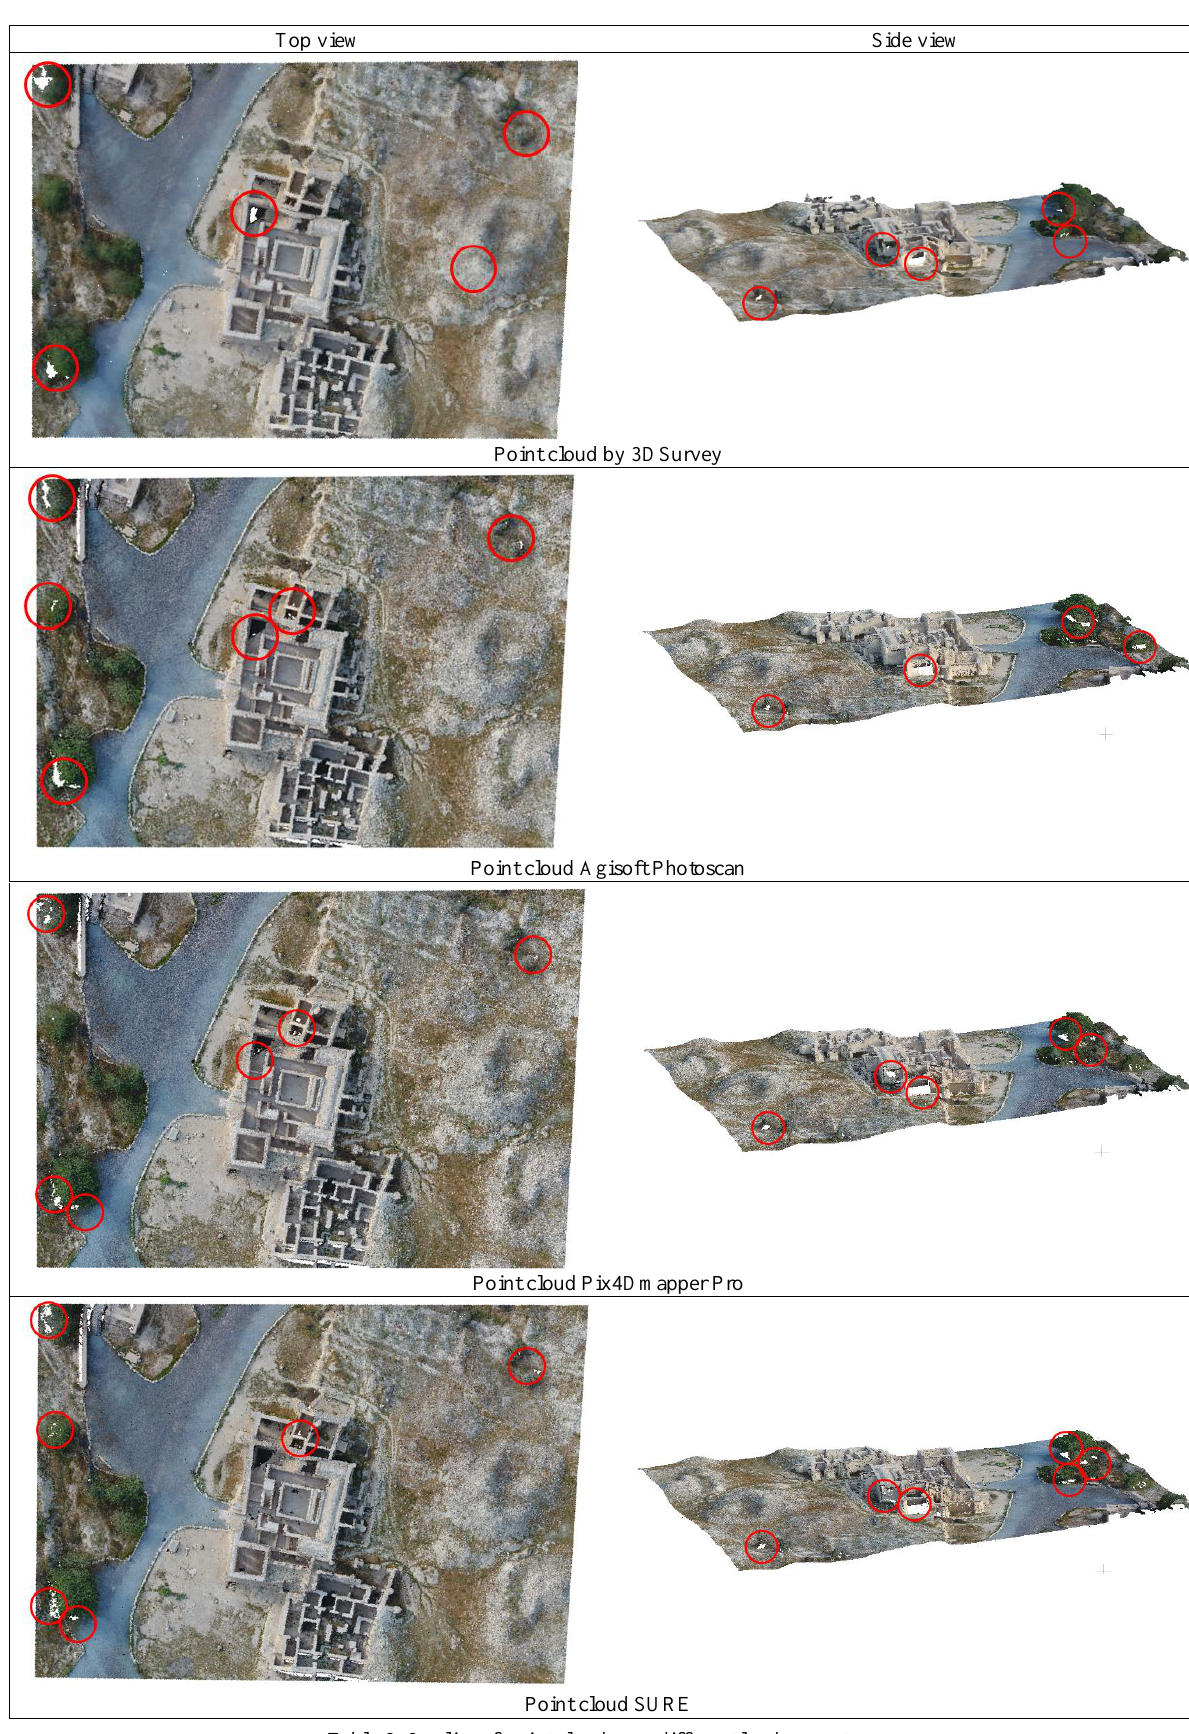
Table 2. Quality of point cloud over different land cover